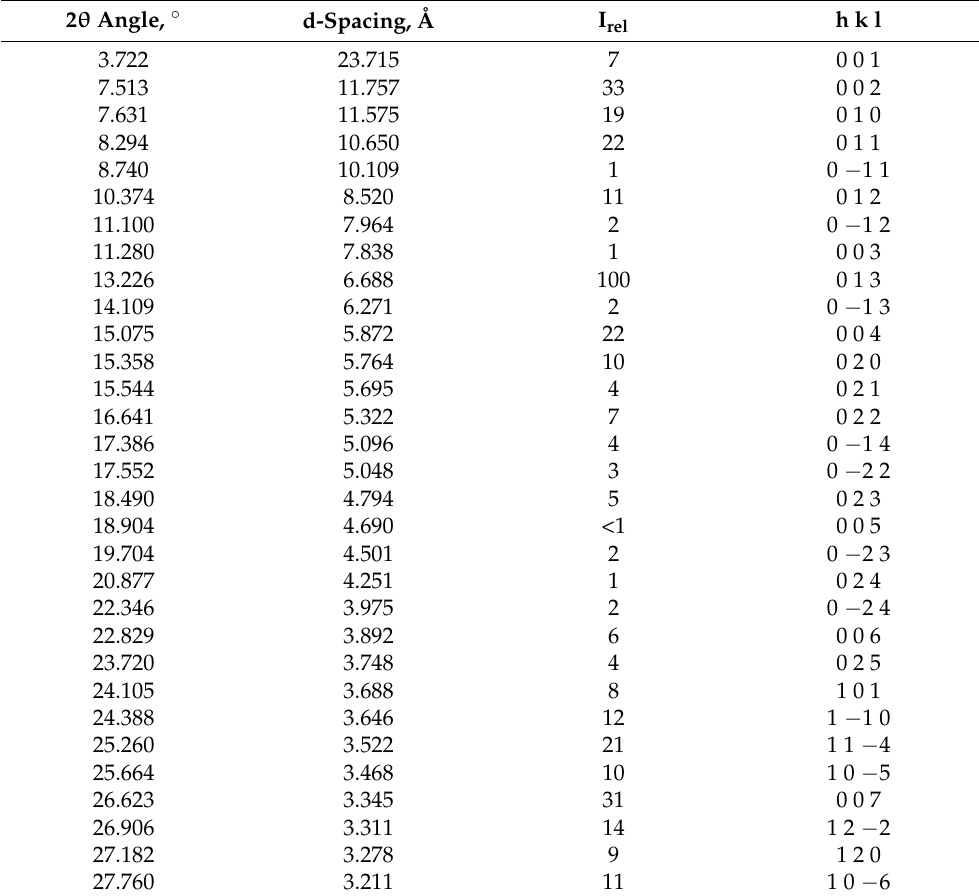
Table 4. List of observed 2 θ angles, d-spacings, and relative intensities, jointly with reflection indices, for Eltrombopag Form XII.